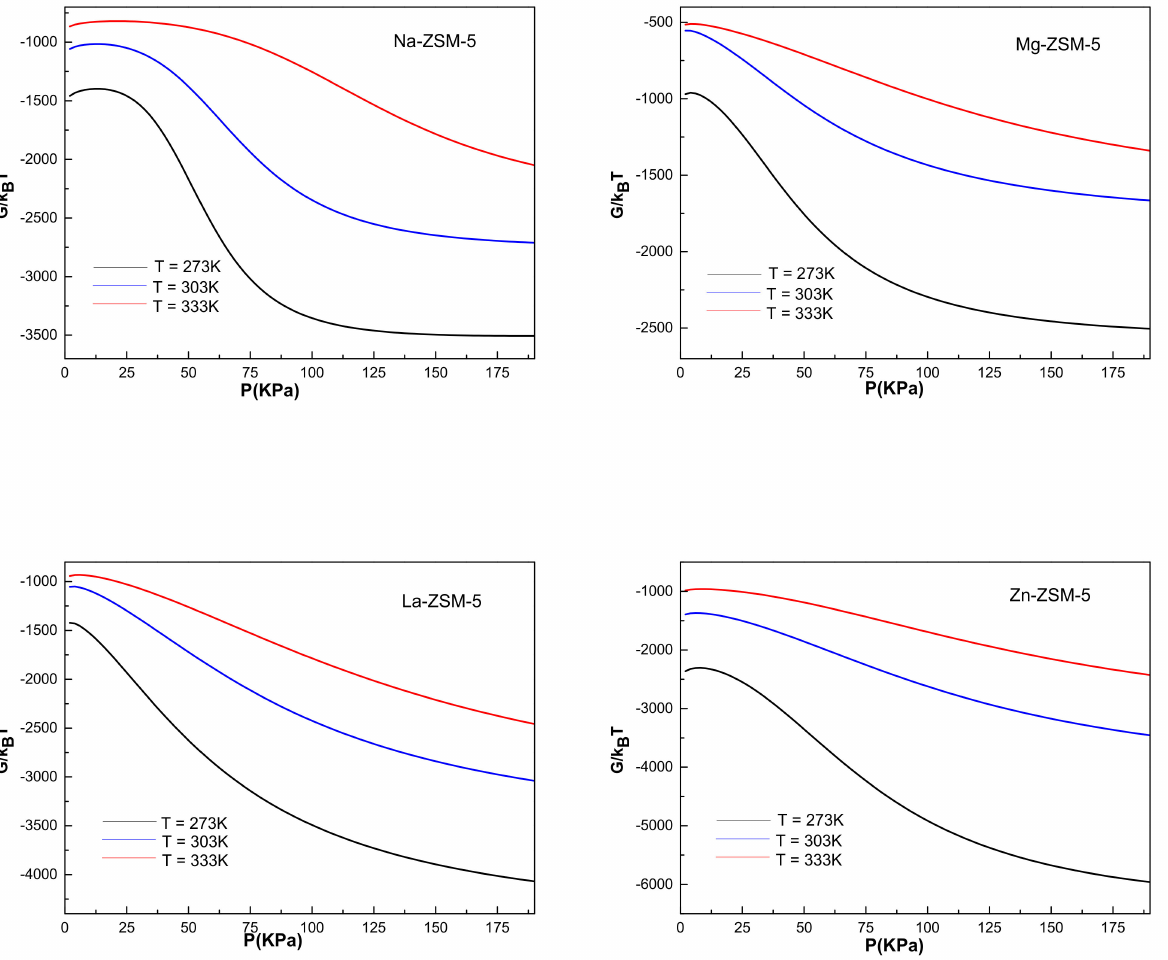
Figure 11. Evolution of Gibbs free energy versus pressure for the four tested systems at three